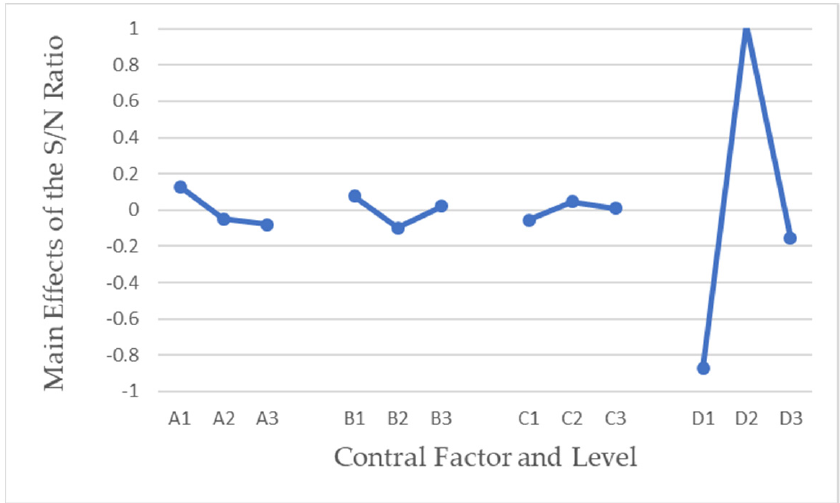
Figure 5. Main effects of S/N ratio for multiobjective optimization.